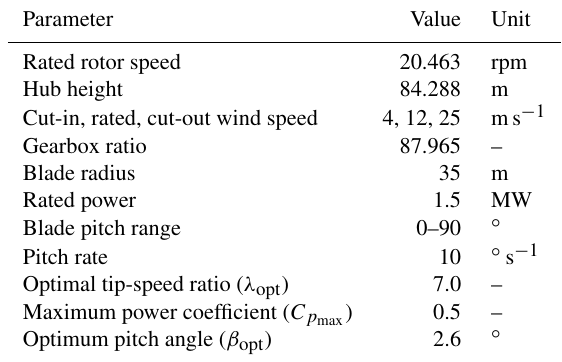
Table 1. The 1.5MW WindPACT reference wind turbine specifica-